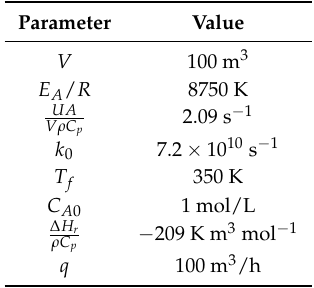
Table 3. Reactor parameter values.